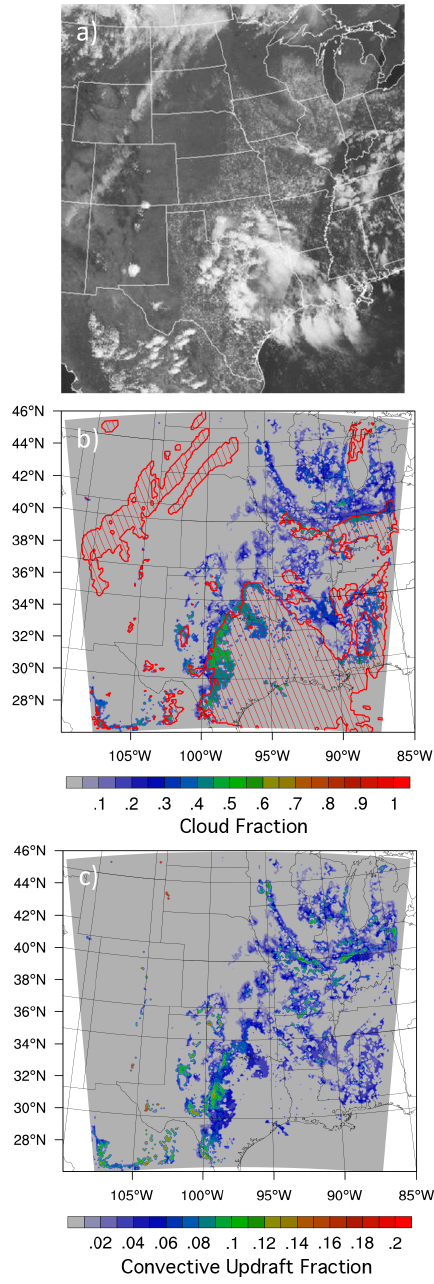
Figure 2. GOES visible satellite image valid at 20:15UTC, 25 June 2007 (a) , and simulated cloud fraction associated with the KF–CuP parameterization (colors), areas with grid-resolved clouds (hashed; b ), and fraction of model grid box with convective updrafts (c) . Note the different color scales used in plots of cloud fraction (b) and convective updraft fraction (c)